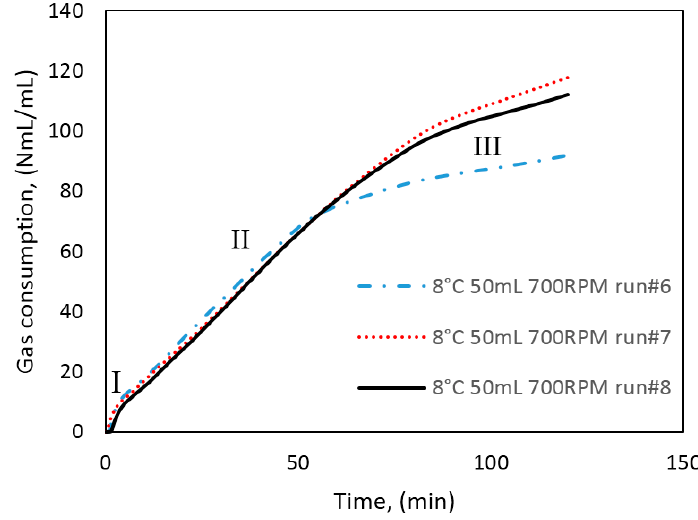
Figure 9. Three experiments performed under similar conditions (50 mL water, 141.4 mL cell), showing the effects of mass transfer restriction and agglomeration as we go from growth stage I through II and III.